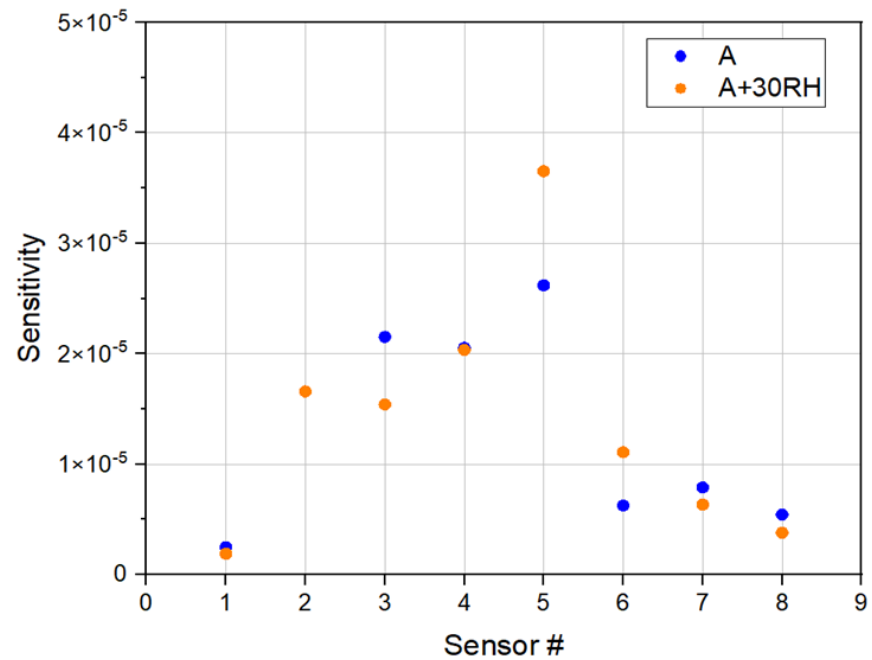
Figure 7. Comparison of the response sensitivities of the individual sensors in the HCD-interfaced sensor array in response to hexane vapor under air and air with a 30% RH sensing environment.